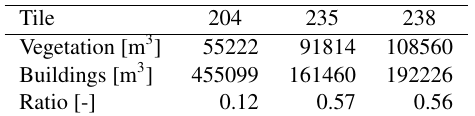
Figure 1. The three selected urban areas (interior square = 250 m) with in colors the segmented tree crowns, in white the filtered points. Table 1. Green and built volume, calculated in a raster 2.5D model. The tiles IDs refer to Figure 1.